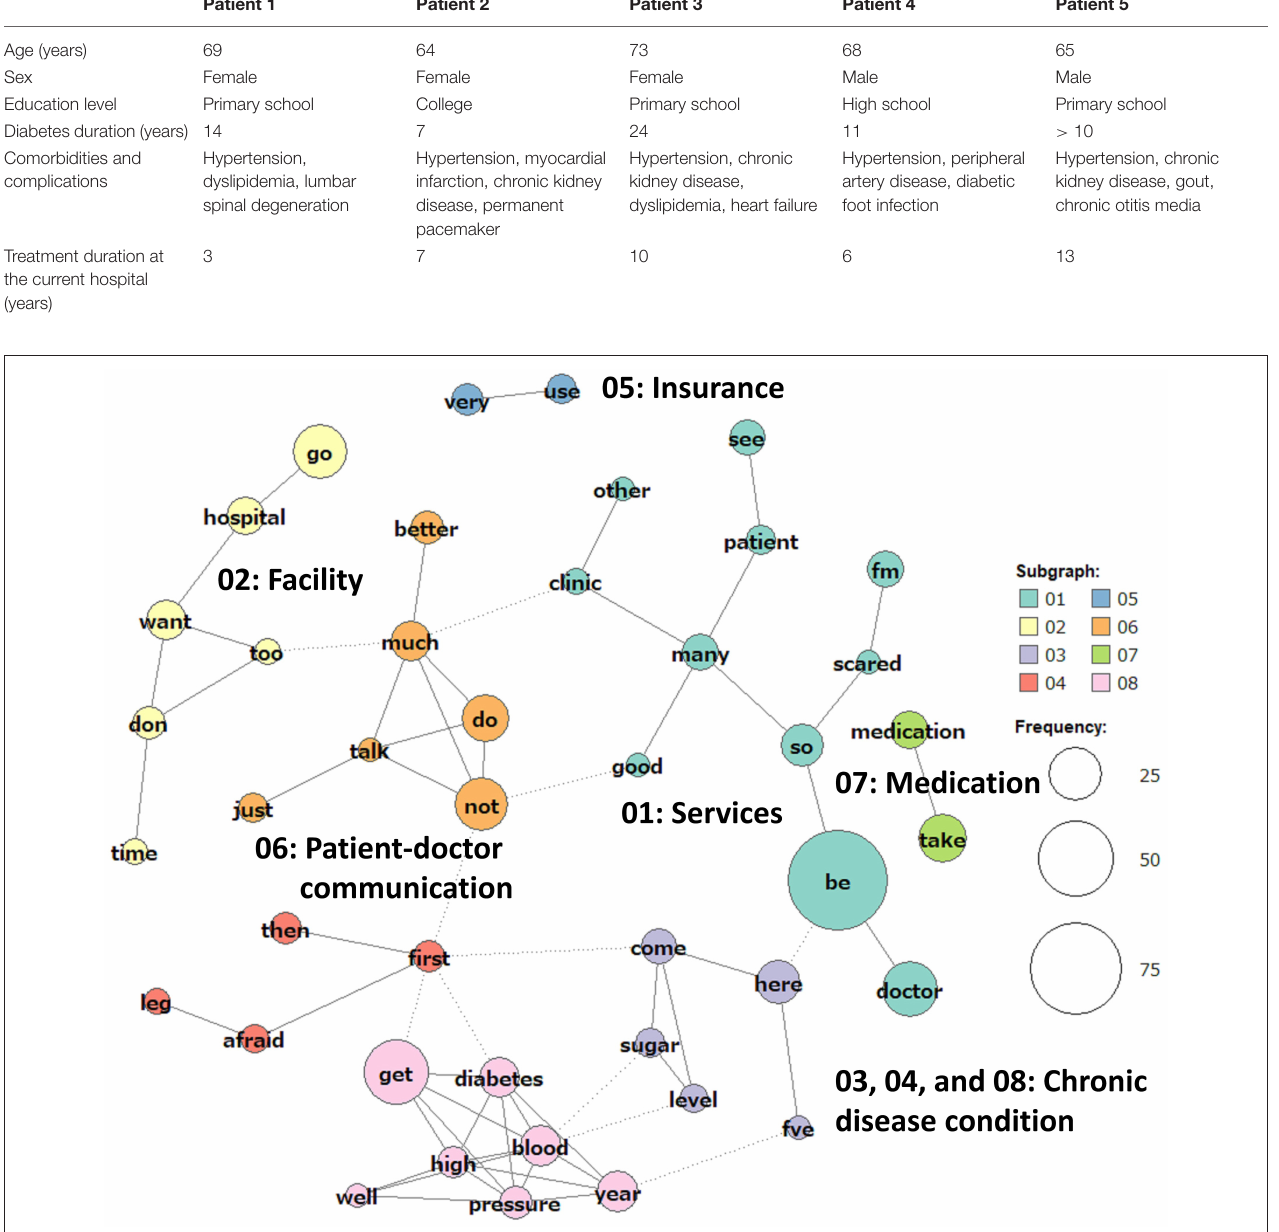
FIGURE 2 | Co-occurrence network of frequently used words. A total of 280 sentences were entered into the KH Coder analysis and 55 words used five times or more were analyzed in the co-occurrence